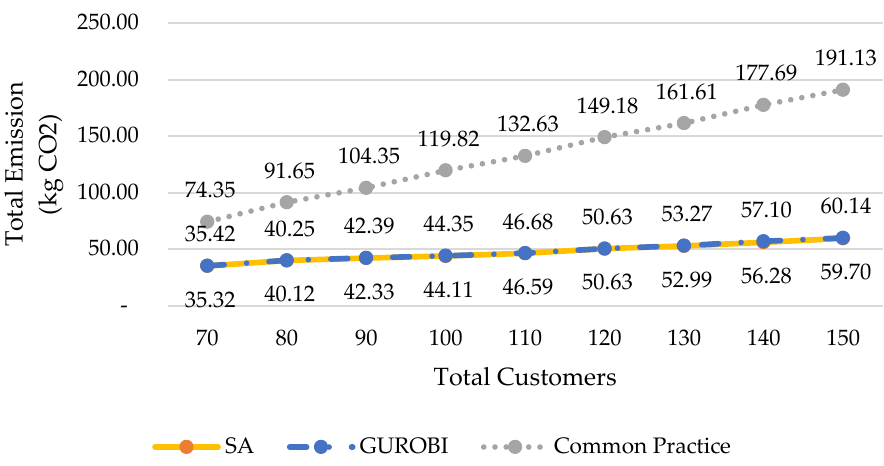
Figure 6. Correlation between total carbon emission and customers.